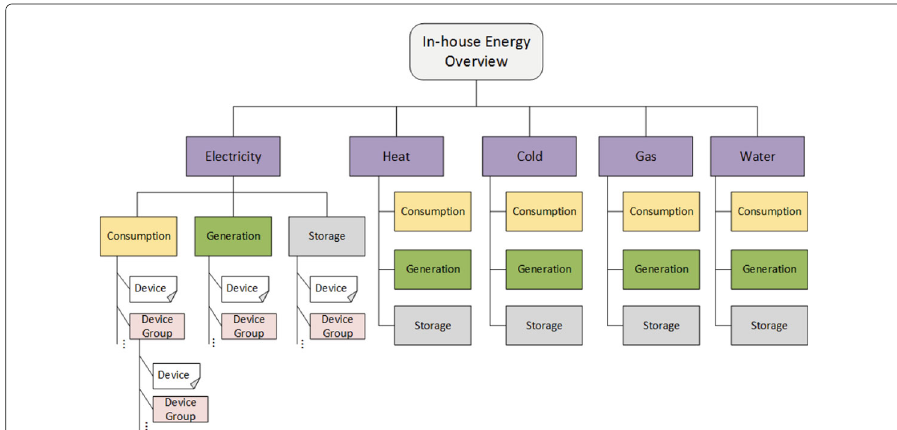
Fig. 8 The data structure of energy overview provided by the generic user interface